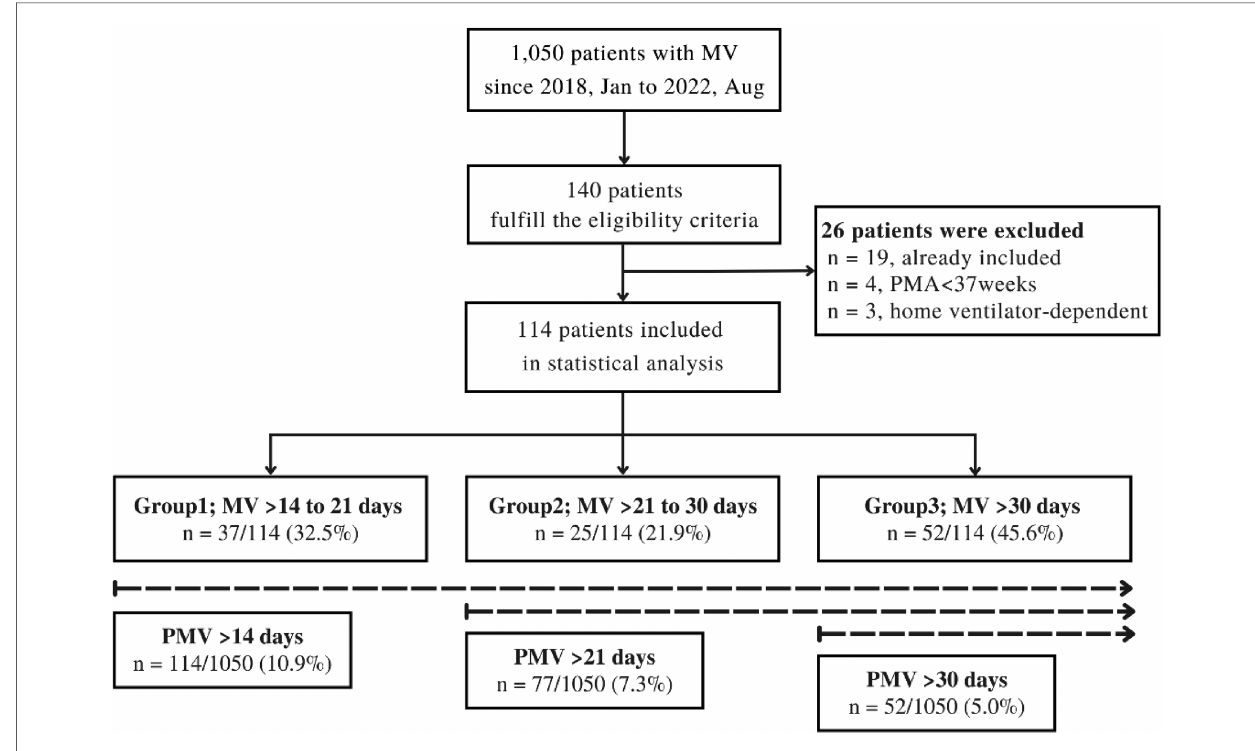
FIGURE 1 Flow diagram of study design. MV, mechanical ventilation; PMA, postmenstrual age; PMV, prolong mechanical